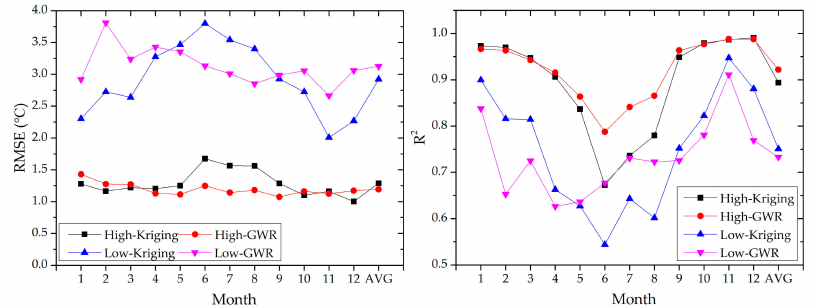
Figure 7. RMSE and R 2 of the predicted monthly mean near surface air temperature (NSAT) using geographically weighted regression (GWR) and Kriging models in China in 12 months of 2010 considering the station density. High-Kriging represents predicting monthly mean NSAT using the Kriging model in the region with high station density; High-GWR represents predicting monthly mean NSAT using the GWR model in the region with high station density; Low-Kriging represents predicting monthly mean NSAT using the Kriging model in the region with low station density; Low-GWR represents predicting monthly mean NSAT using the GWR model in the region with low station